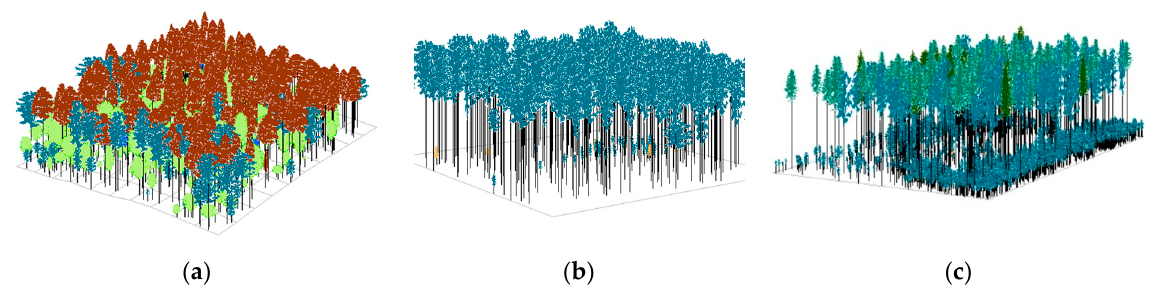
( b ) Figure 6. ( a ) Variation in the Shannon index (H5) in relation to stand age, and ( b ) Shannon diversity calculated at the level of the mean diameter and height of the stands. The age, mean diameter, and mean height of the stands did not have a significant influence on the H-index values by diameter (H4) or height (H5). However, 61% (273) of the stands had the same H-index values, indicating the diversity in diameter (H4) and height (H5). Thus, 70% of the H4 variation was reproduced by the relationship expressed in (b). At the stand level, the indices had different values. A value of 0 for all indices was